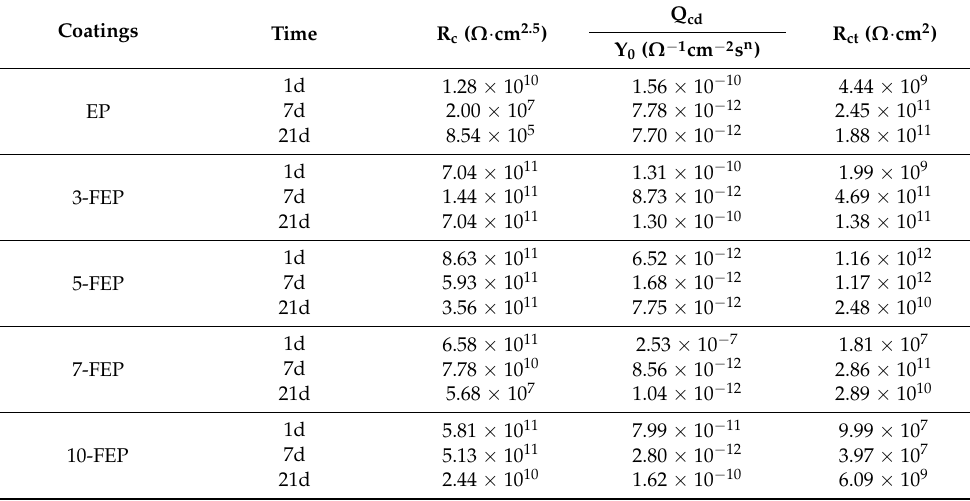
Figure 13. Nyquist of the composite coatings: ( a ) 1 day, ( b ) 7 day, ( c ) 21 day; Bode plots of the composite coatings: ( d ) 1 day, ( e ) 7 day, ( f ) 21 day. Table 2. The electrochemical parameters extracted from EIS data of the coating.